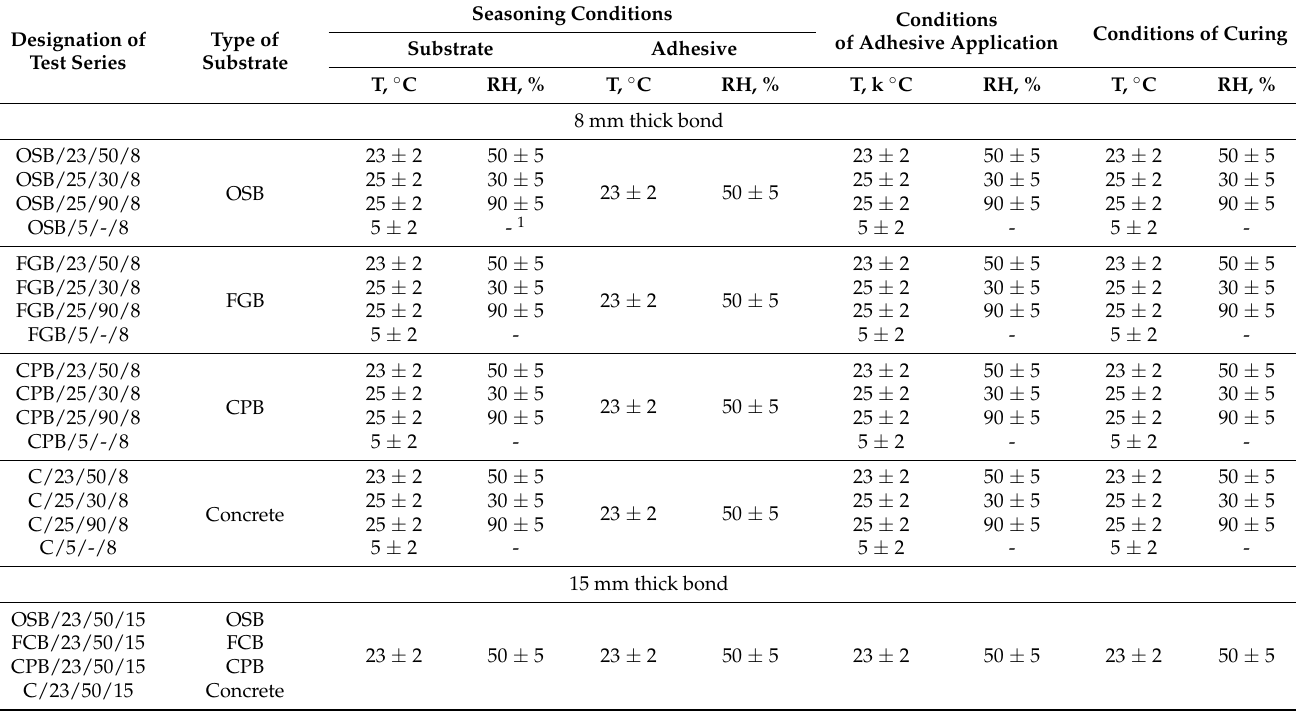
Table 3. Conditions of sample preparation for bond strength